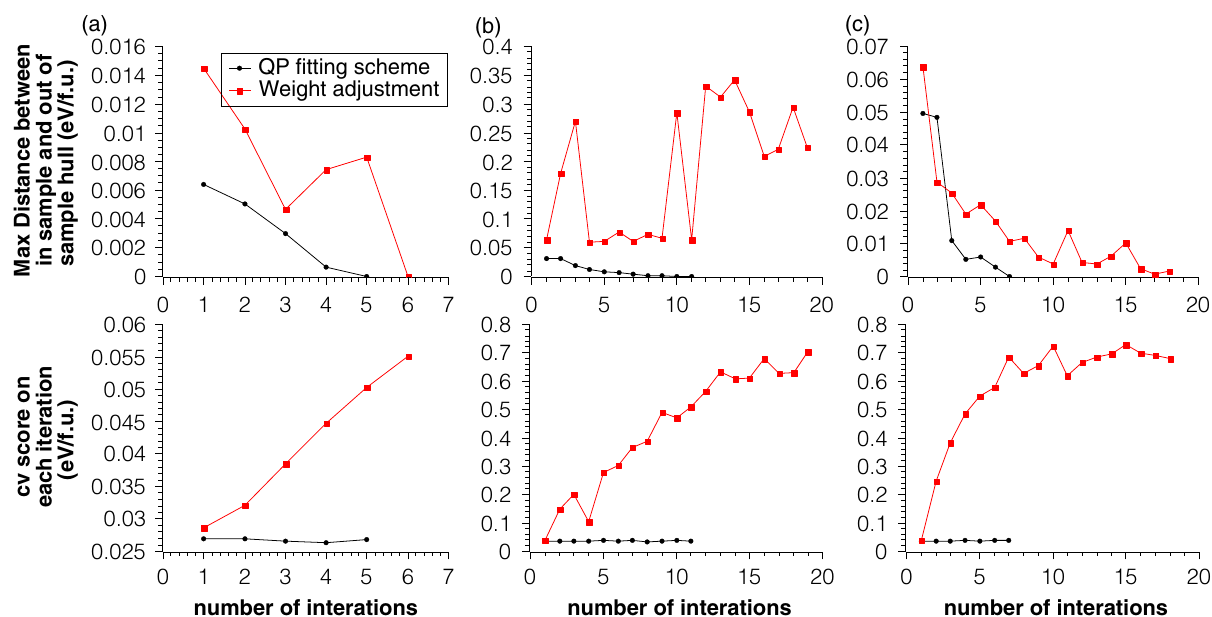
Fig. 6 Results of the iterative construction of cluster expansion models with out-of-sample ground-state preservation for ( a ) Li x Fe (1 − x ) O, ( b ) Li x Ti (1 − x ) O based on the exact ground states up to a supercell size of 16 sites and ( c ) Li x Ti (1 − x ) O based on the simulated annealing with a supercell size of 8 × 8 × 8 (512 sites). The upper panels show the maximal distance between the in-sample and out-of-sample hulls, and the lower panels show the corresponding cross-validation scores. For comparison, the corresponding results using iterative adjustment of con fi guration weights is shown as red lines and